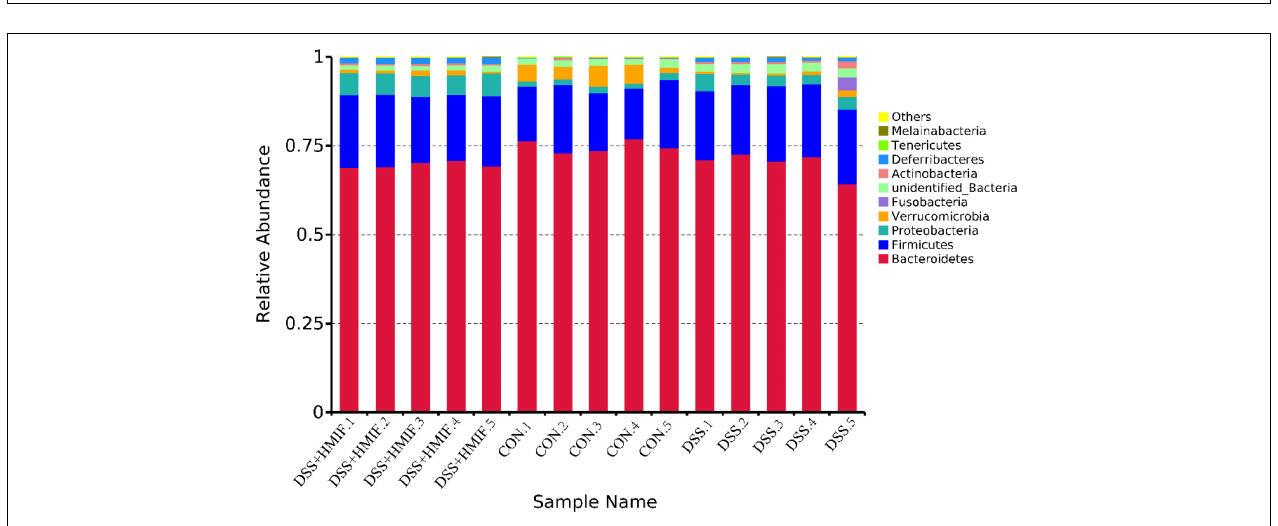
FIGURE 5 | Comparison of the colonic microbiota composition among the three groups. A principal coordinate analysis (PCoA) was used to visualize the weighted UniFrac distances of the fecal samples from the C57BL/6J mice. CON, control; DSS, dextran sulfate sodium (DSS) treatment; HMIF, DSS treatment + 200 mg/kg fruiting bodies of Morchella importuna (MIF).